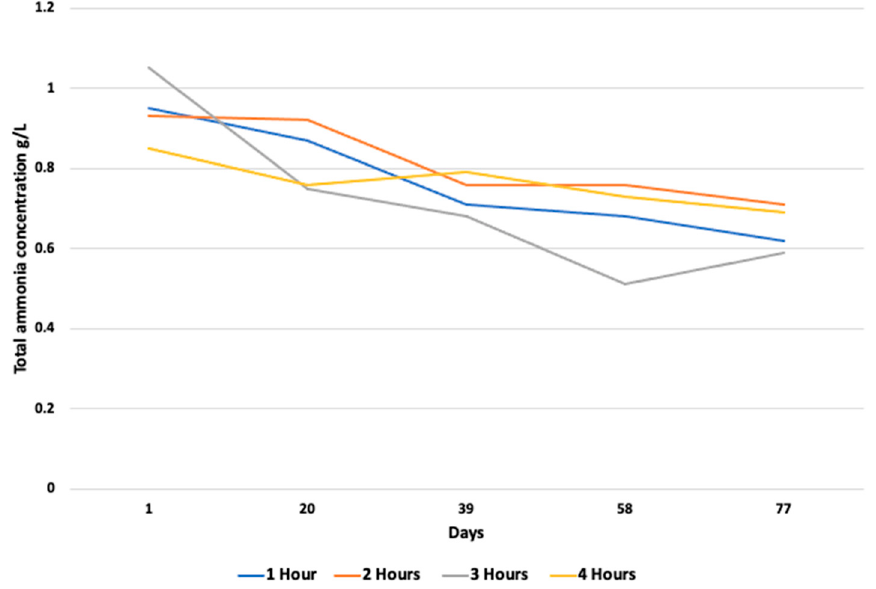
Figure 7. Total ammonia concentrations during the entire